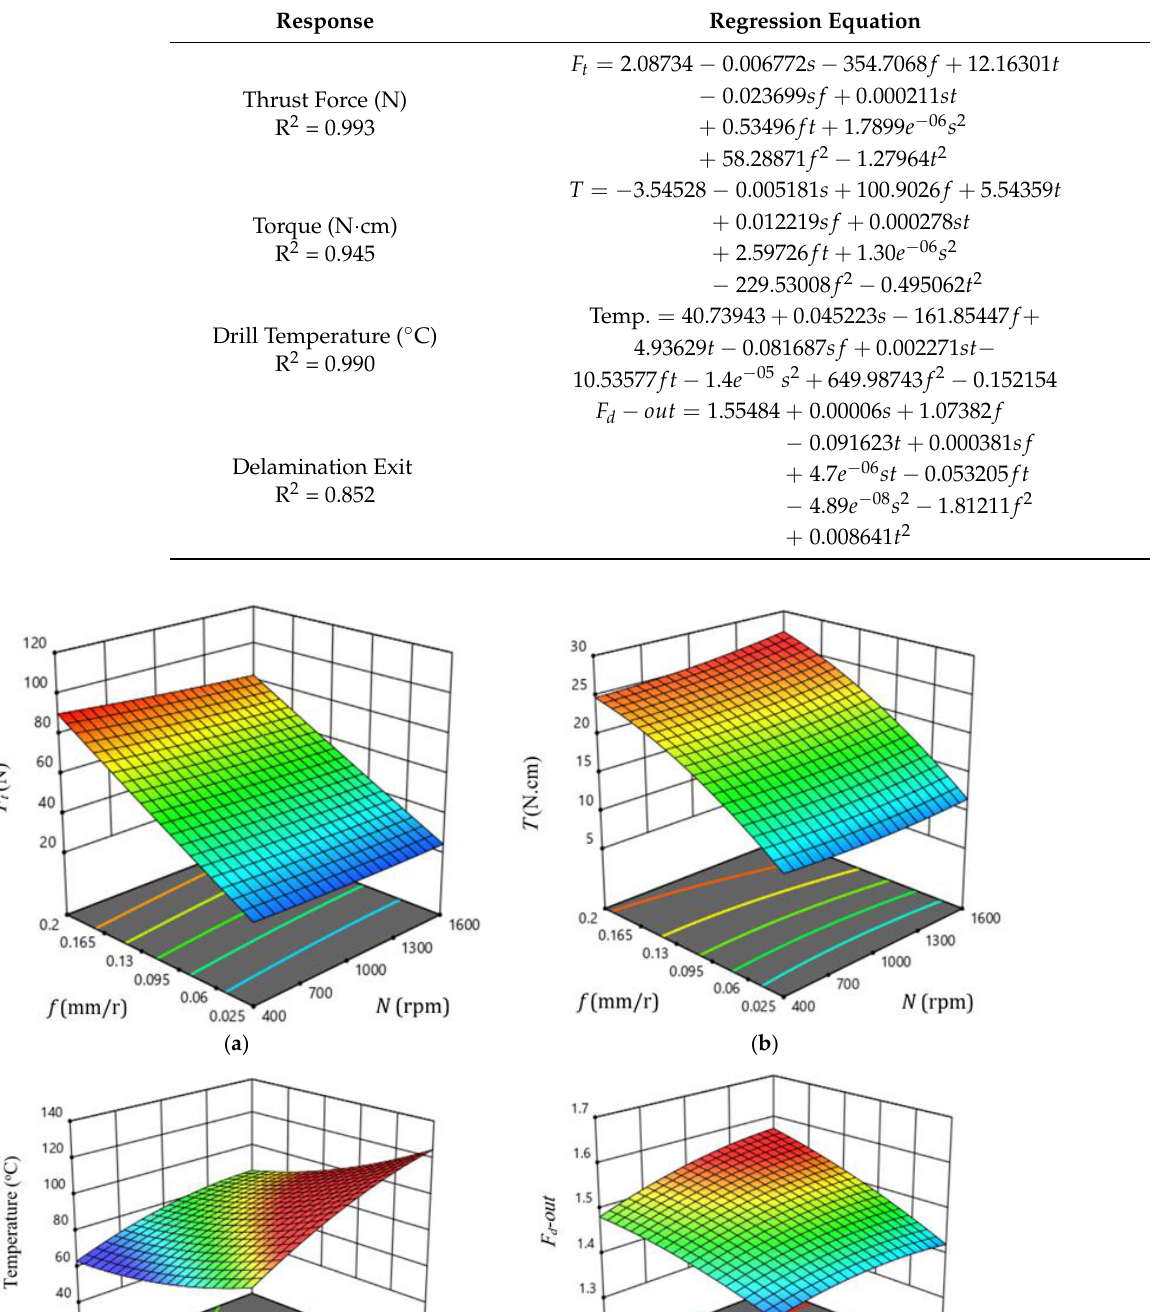
Table 6. Nonlinear regression model for machinability responses.